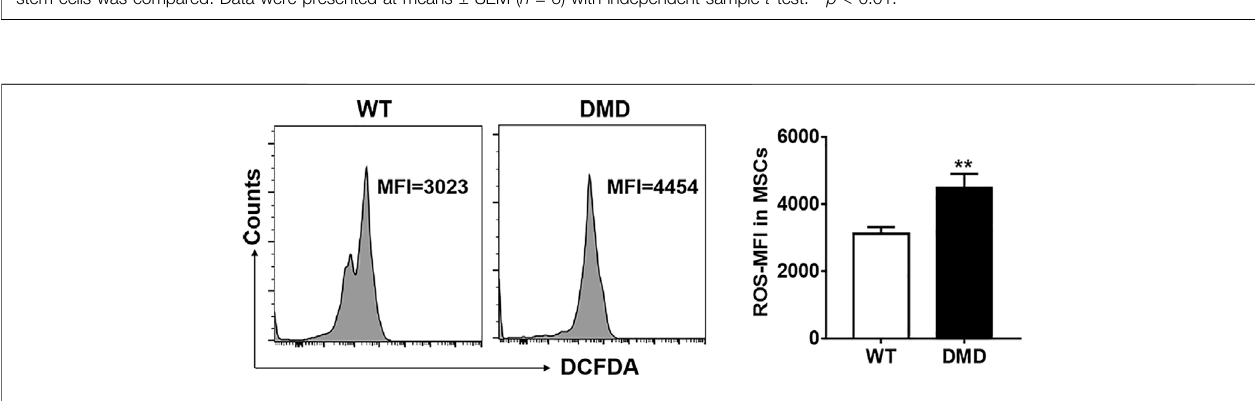
Frontiers in Cell and Developmental Biology |